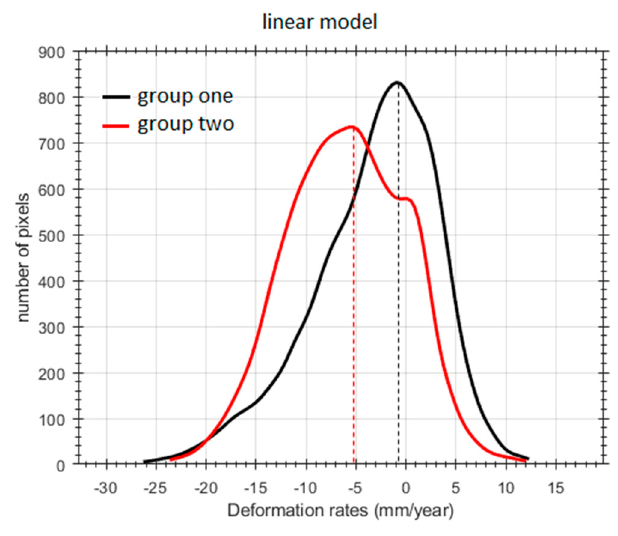
Figure 5. Deformation histogram velocities for the first (black) and second (red) groups.